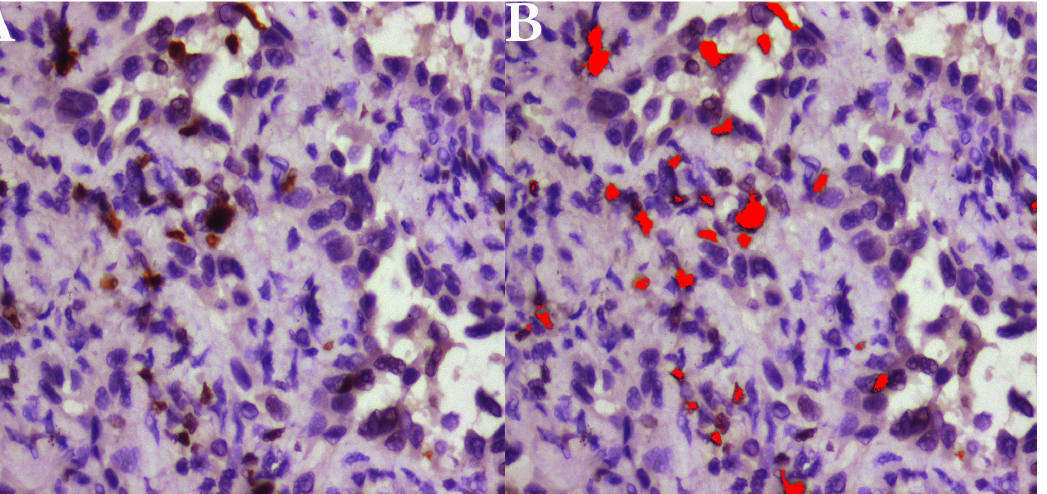
Fig 3. Representative immunohistochemical detection and measurement of Ki-67 labeling index (LI) (magnifyication ×400). (A) A case with positive expression of Ki-67 presenting tan particles located in nucleus of proliferating cells. (B) Quantitative measurement of Ki-67 LI by Image Software Pro Plus 6.0 (red area means detection of the software).